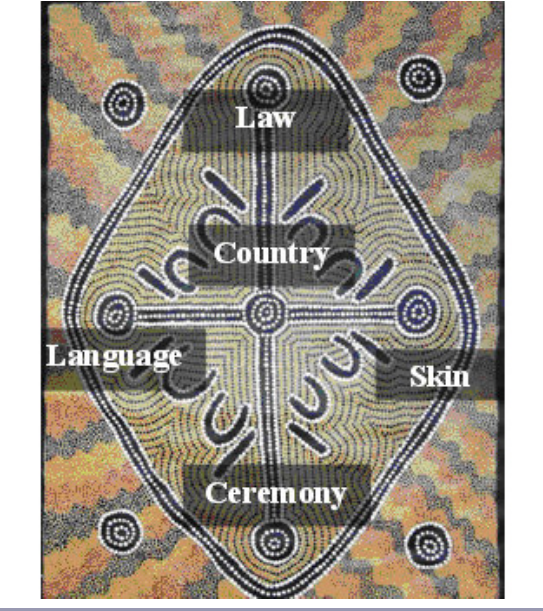
Fig. 2. A graphical representation of the ngurra-kurlu framework for indigenous ecolocial knowledge.